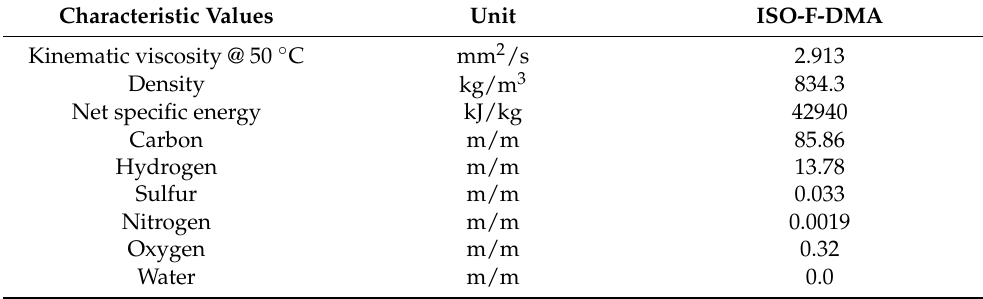
Table 5. Fuel oil